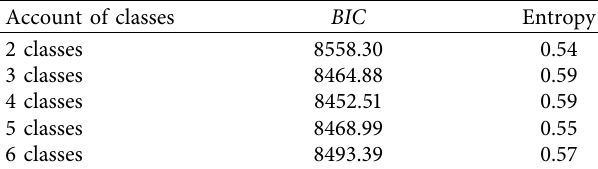
Table 2: Fit indexes of the results of the LCA. Table 1: Reliability, means, standard deviations, and bivariate and